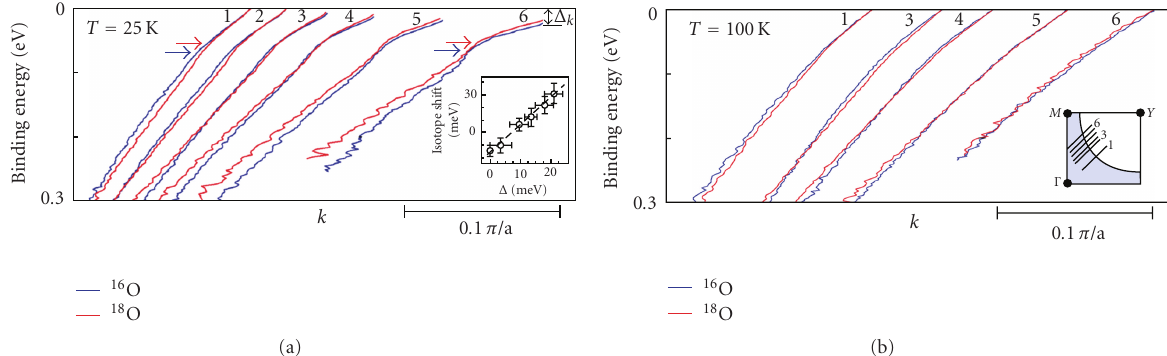
Figure 8: MDC dispersions from cuts parallel to Γ - Y taken o ff node towards the antinodal point. (a) Data taken in the superconducting phase ( T = 25 K). The inset shows the isotope energy shift versus the isotope-averaged superconducting gap, Δ . The isotope shift is measured at the momentum value where the isotope-averaged binding energy is 220 meV. The apparent linear correlation indicated by the dashed line is independent of the binding energy used. (b) MDC dispersions from the same cuts measured above T c ( T = 100K). The inset illustrates the location of the cuts. The figures are from